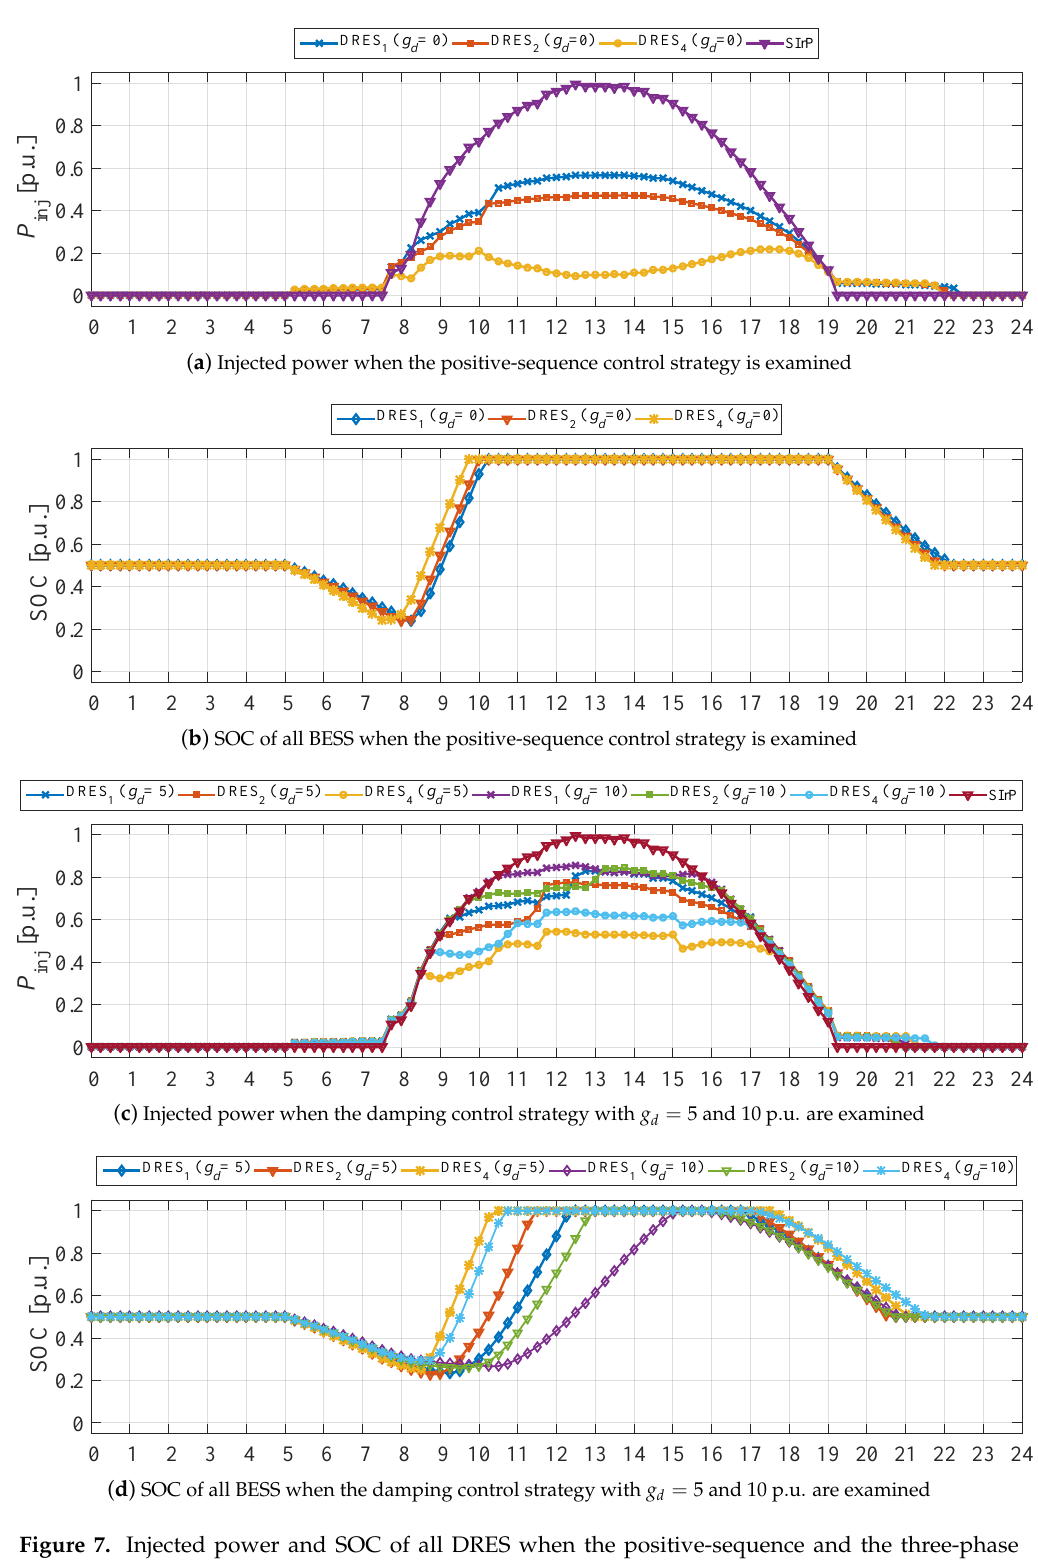
Figure 7. Injected power and SOC of all DRES when the positive-sequence and the three-phase damping control strategies are examined (C1S1, C1S2 and